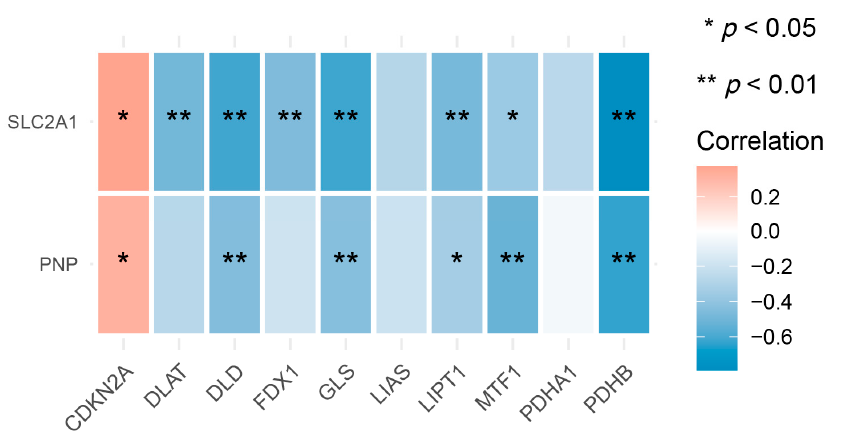
Figure 9. Heatmap of Pearson correlations between key genes and copper-death related genes; red represents a positive correlation, and blue represents a negative correlation.